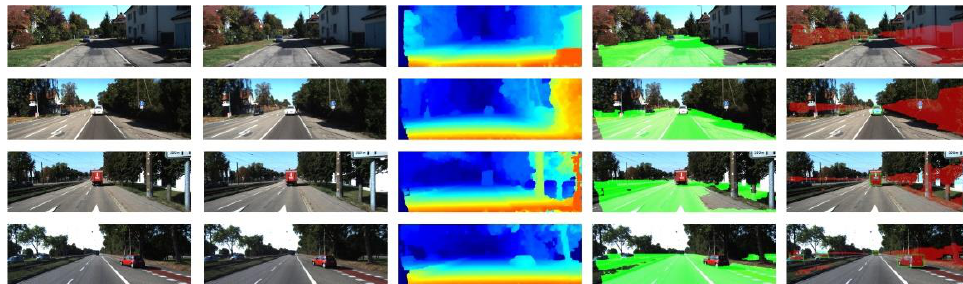
Figure 8. More about the detection results of the KITTI dataset in complex traffic scenarios. From left to right are the right image, left image, disparity image, free space extraction, and obstacle detection.